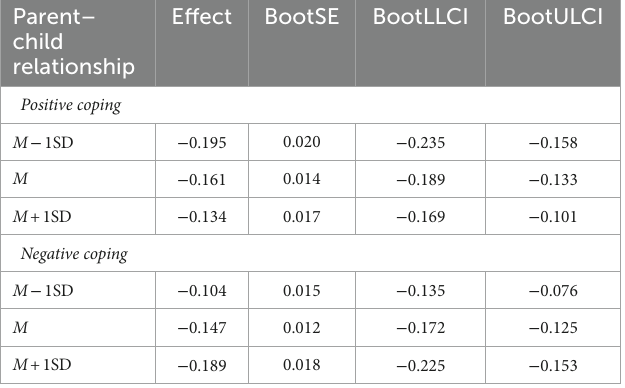
TABLE 6 The coping style adapts to the moderating influence of parent– child